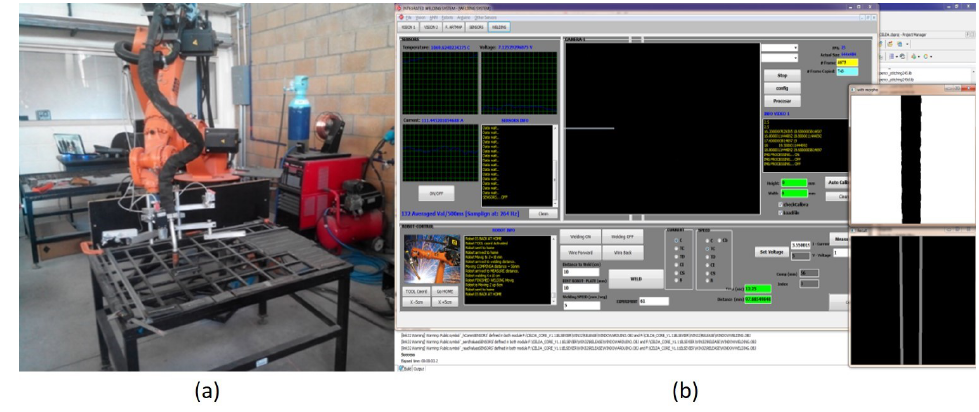
Figure 5. Robot GMAW ( a ) Testbed. ( b ) Graphical User Interface.